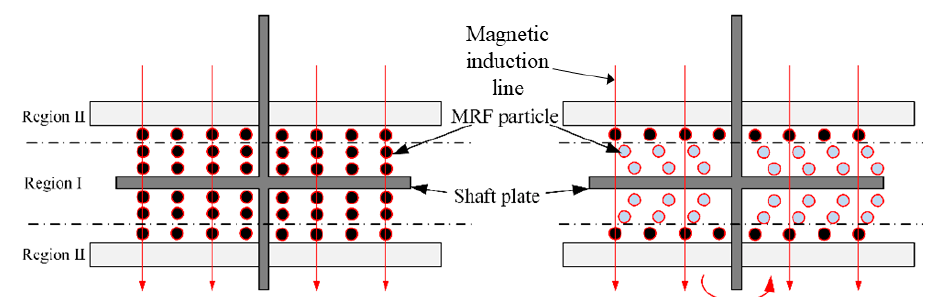
Figure 6. Particle distribution when the disc is